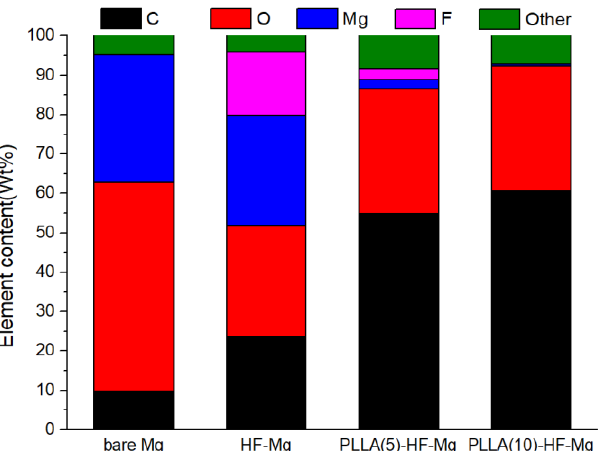
Figure 10. Corrosion surface components of all samples after immersion in SBF for 15 days analyzed by EDS.